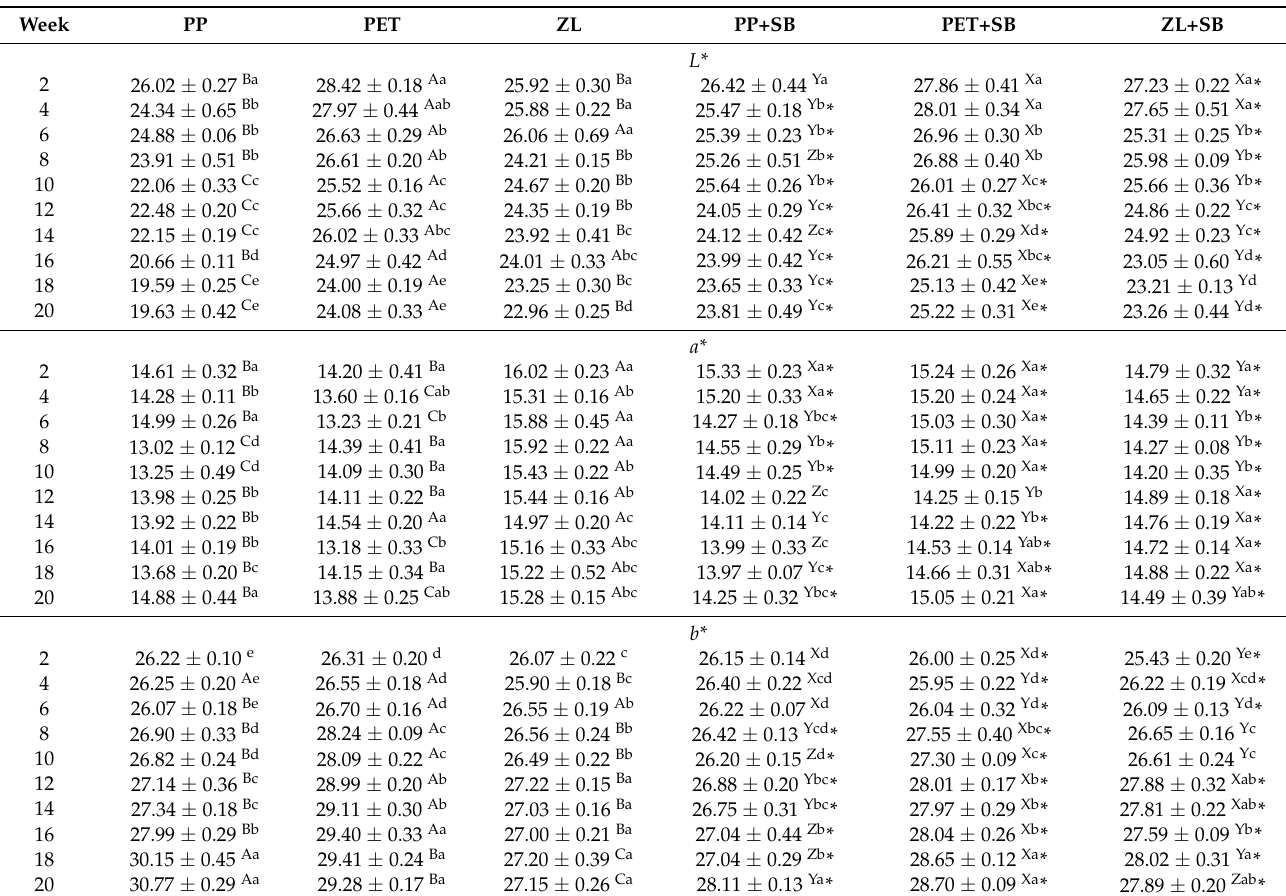
Table 3. Changes in color of dried chili fish paste stored in various packaging at room temperature.